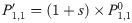
Detection rates against Pr,r for |V| = 20 binary networks with two communities.P1,1′=(1+s)×P1,10, s = (5,50).